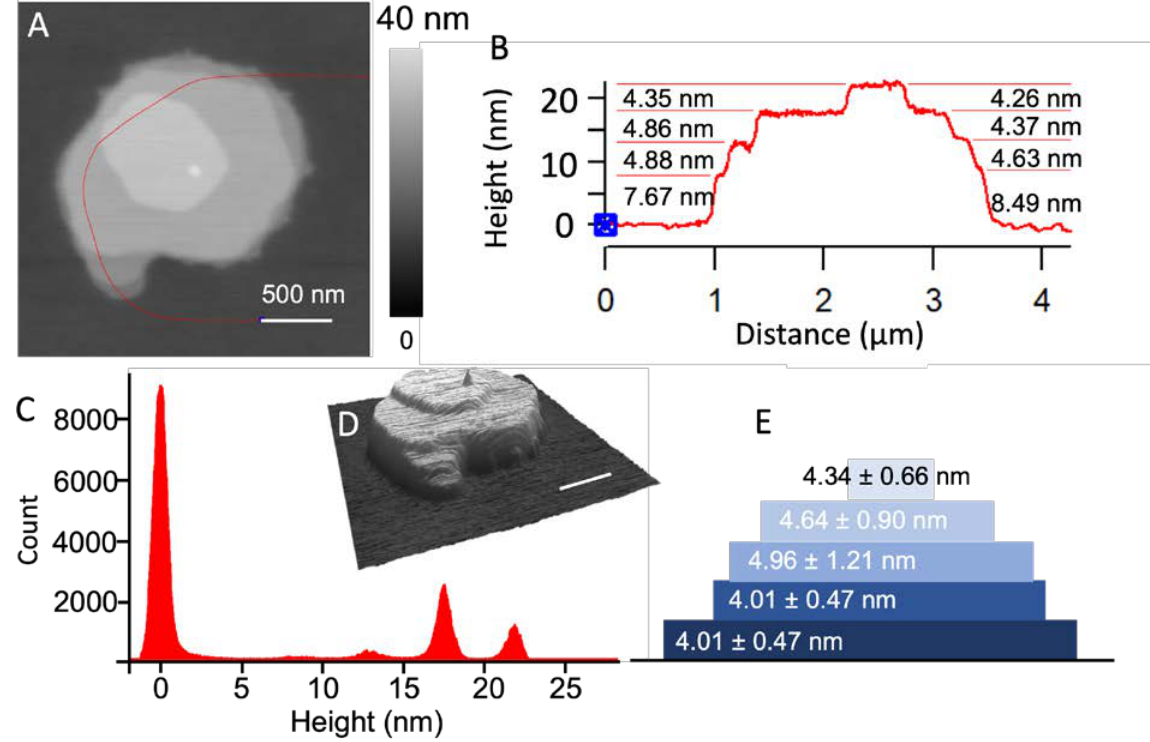
Figure 2. ( A ) AFM topographic image of a POPC feature formed during single-drop delivery. ( B ) Cursor profile indicated by the red line in ( A ). ( C ) Histogram of the topographic height measure- ments in ( A ). ( D ) A 3D display of ( A ). ( E ) Schematic diagram of the lipid structure produced in ( A ), i.e., five POPC bilayers stacking atop each other.